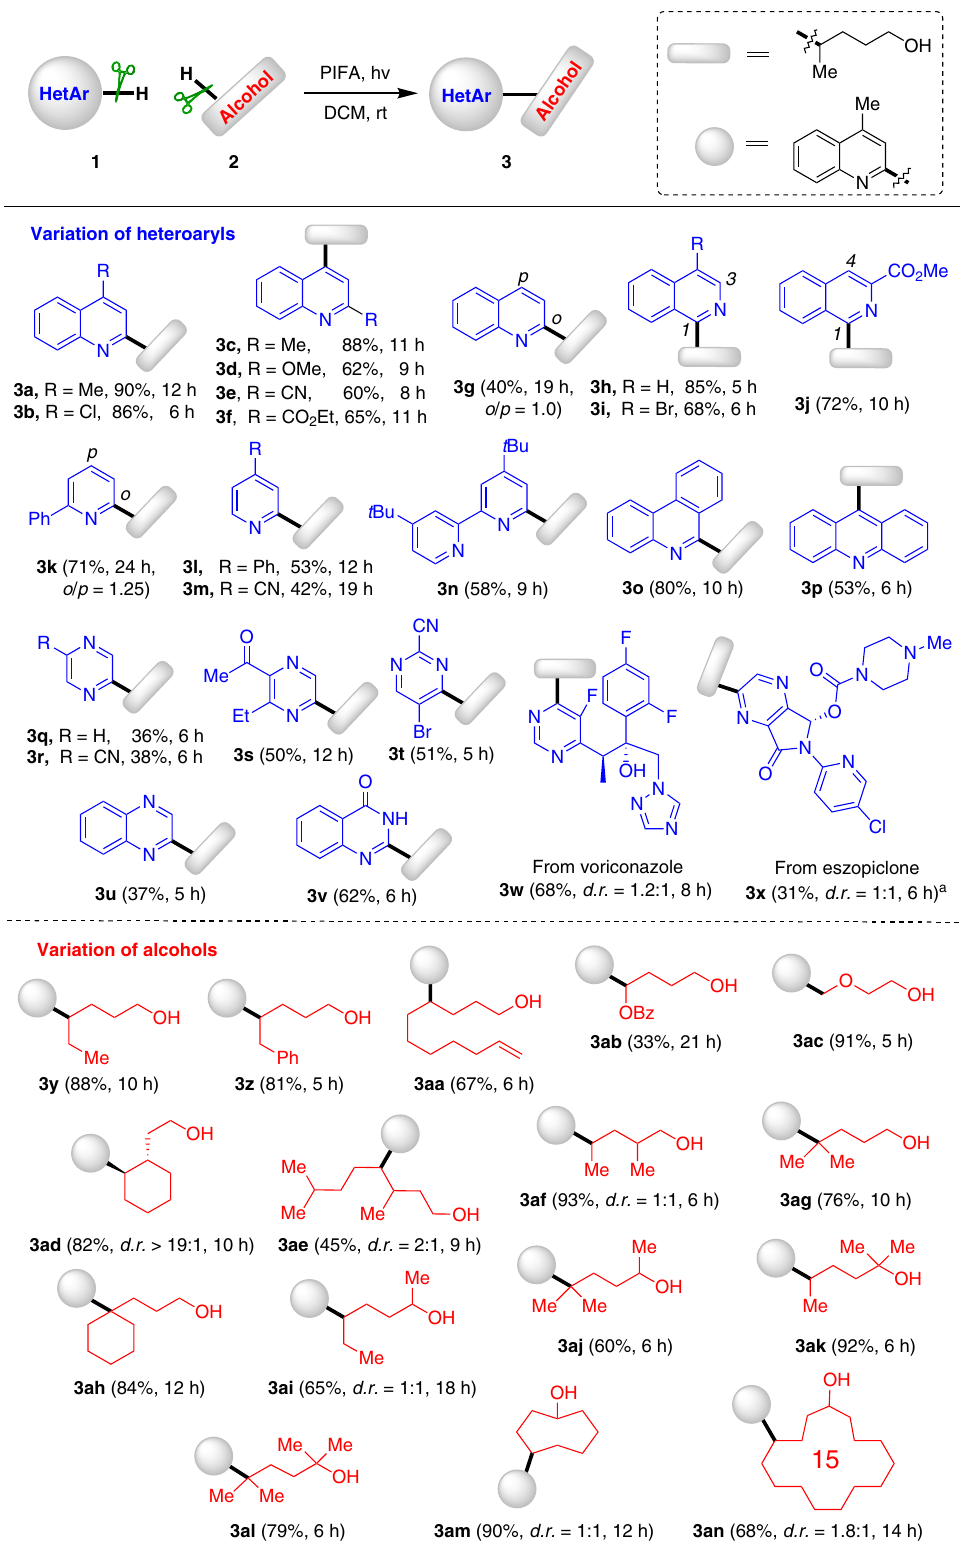
Fig. 2 Scope of heteroaryls and alcohols. Reaction conditions: heteroaryl 1 (0.4 mmol), alcohol 2 (2.0 mmol), and PIFA (0.92 mmol) in DCM (2 mL), irradiated by 100 W blue LEDs, rt. Yields of isolated products are given. a 1.5 equiv. TFA was added. PIFA: phenyliodine bis(tri fl